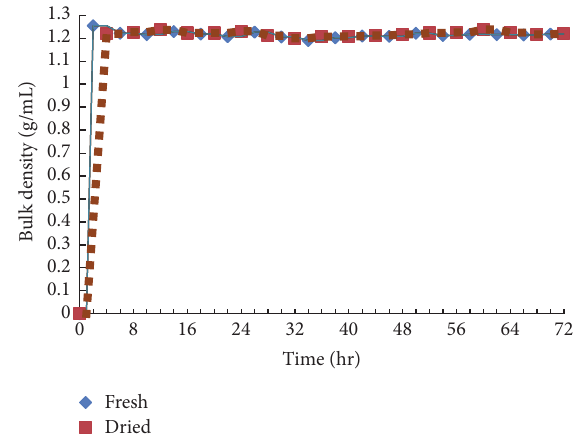
Figure 2: Conventional kinetic equilibrium extraction of Clinacan- thus nutans fresh and dried leaves ( 𝑛 = 3 ).